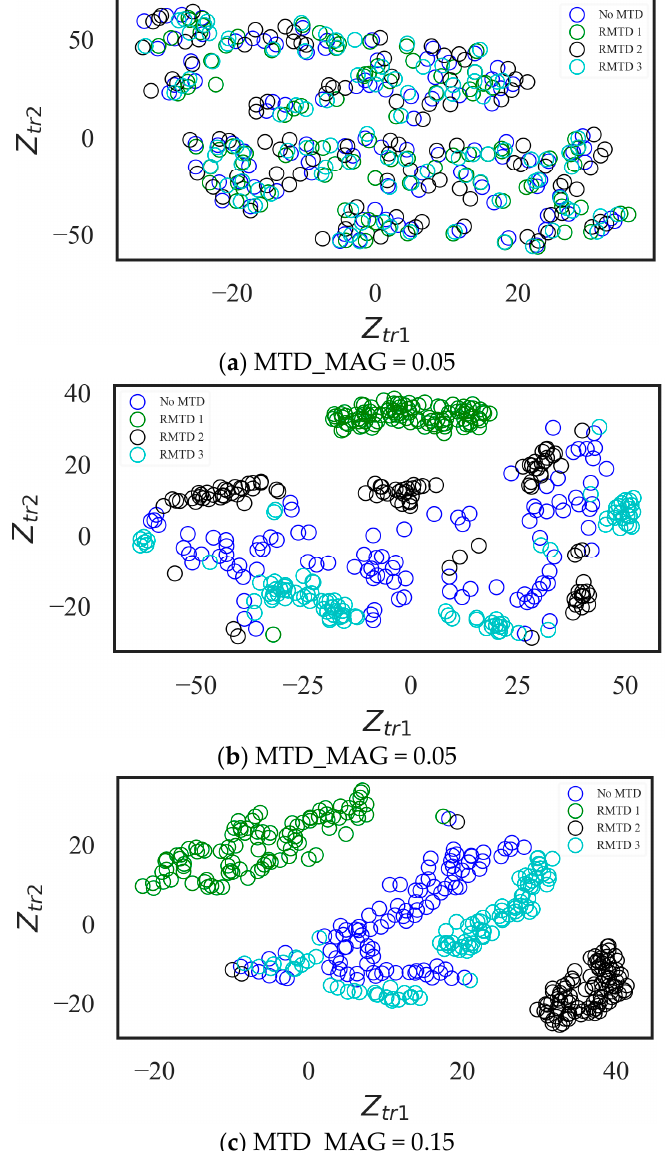
Figure 9. The projection of RMTD and no MTD measurements in the ℝ 2 space by PCA under different MTD magnitudes.